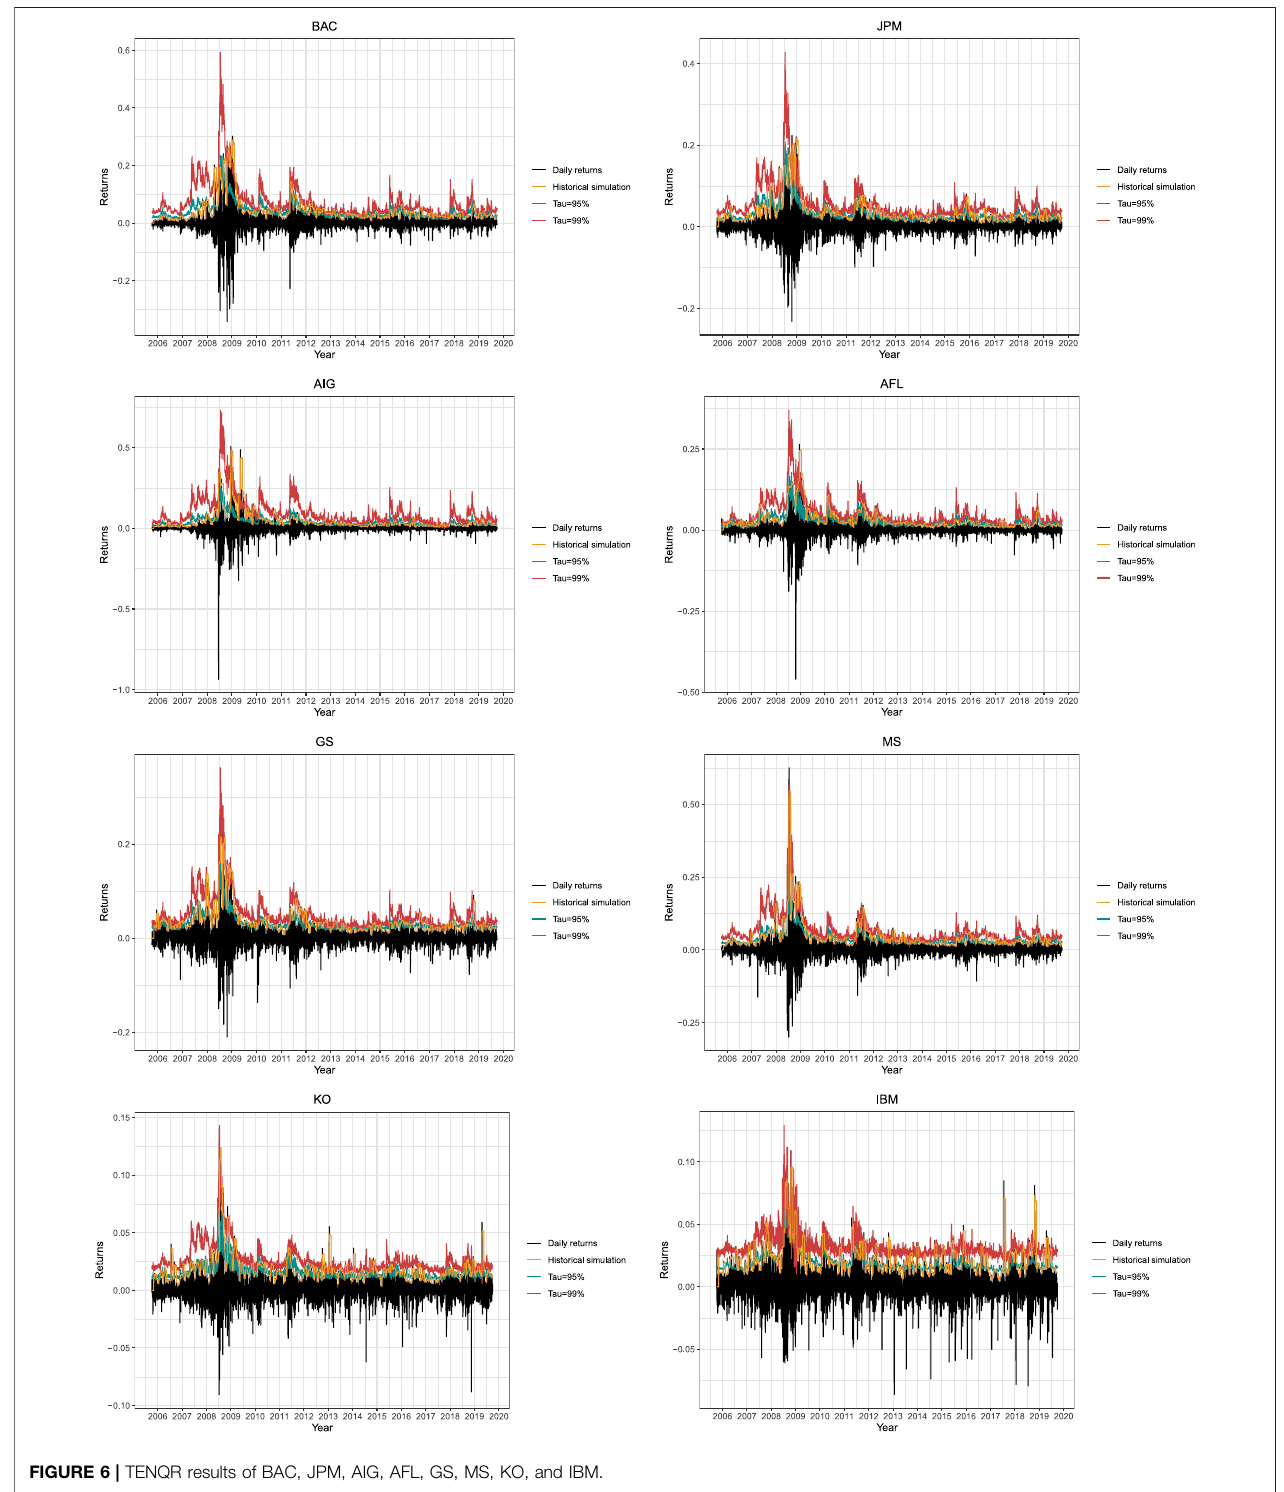
FIGURE 6 | TENQR results of BAC, JPM, AIG, AFL, GS, MS, KO, and